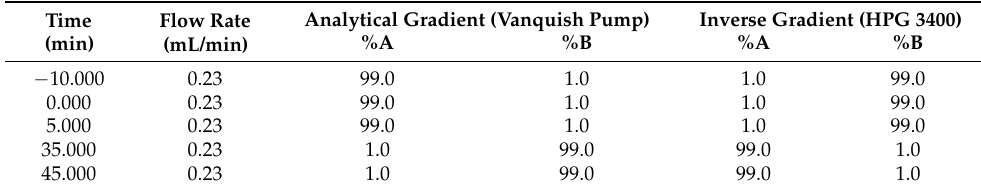
Table 1. Analytical and inverse gradient